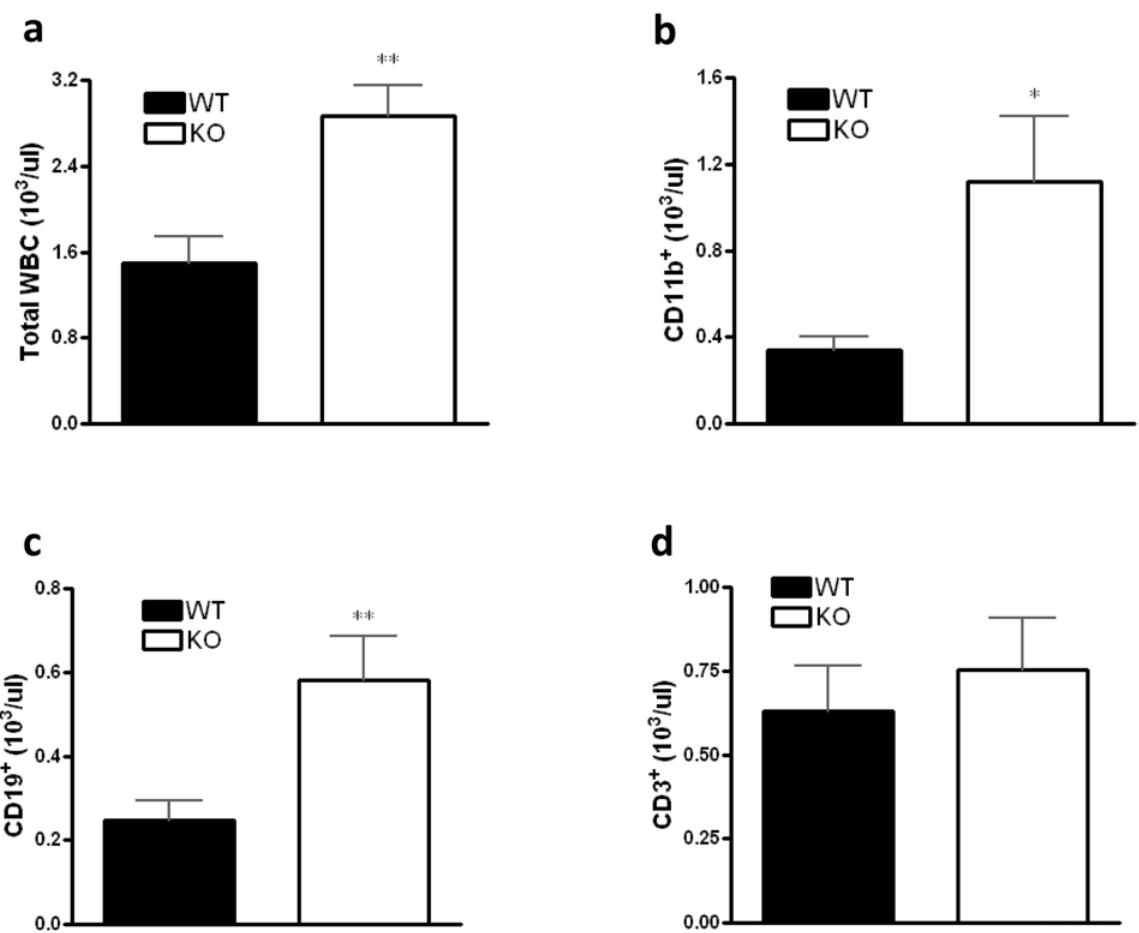
Figure 6. Effect of CB 2 receptor inactivation on the leukocyte cell subsets in the blood during CLP. Numbers of total white cell (a) , as well as CD11b + (b) , CD19 + (c) , and CD3 + (d) cells were monitored in blood by flow cytometric analysis after 16 hours of sepsis induced by CLP. Data are the mean 6 SEM of n =6–9 mice per group. * p , 0.05; ** p , 0.01.